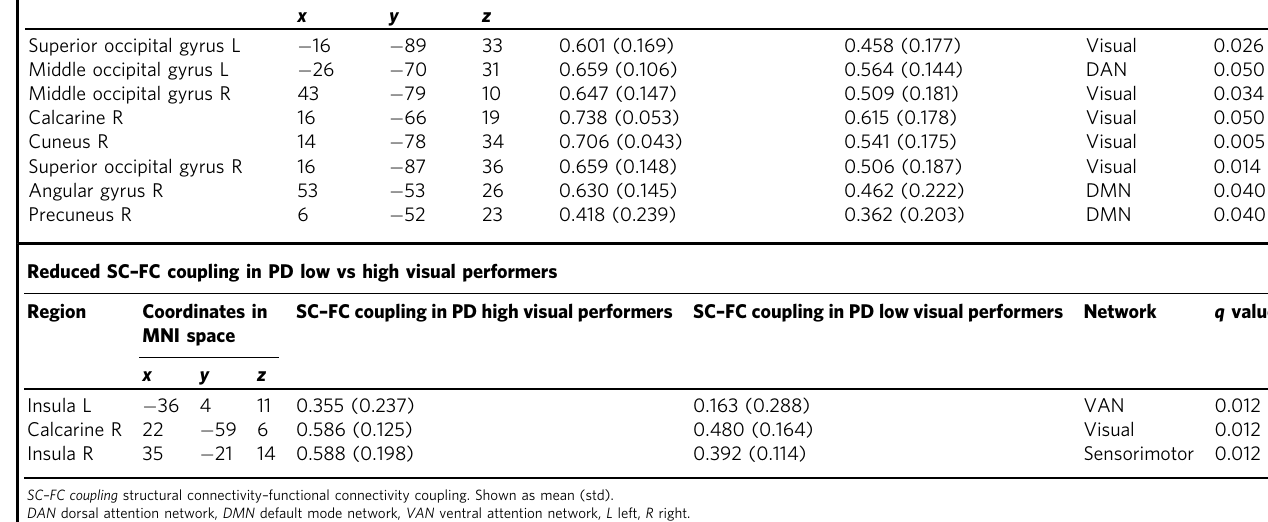
(Fig. 5B, Table 3 and Supplementary Table 3 for the full neurotransmitter gene expression results.).